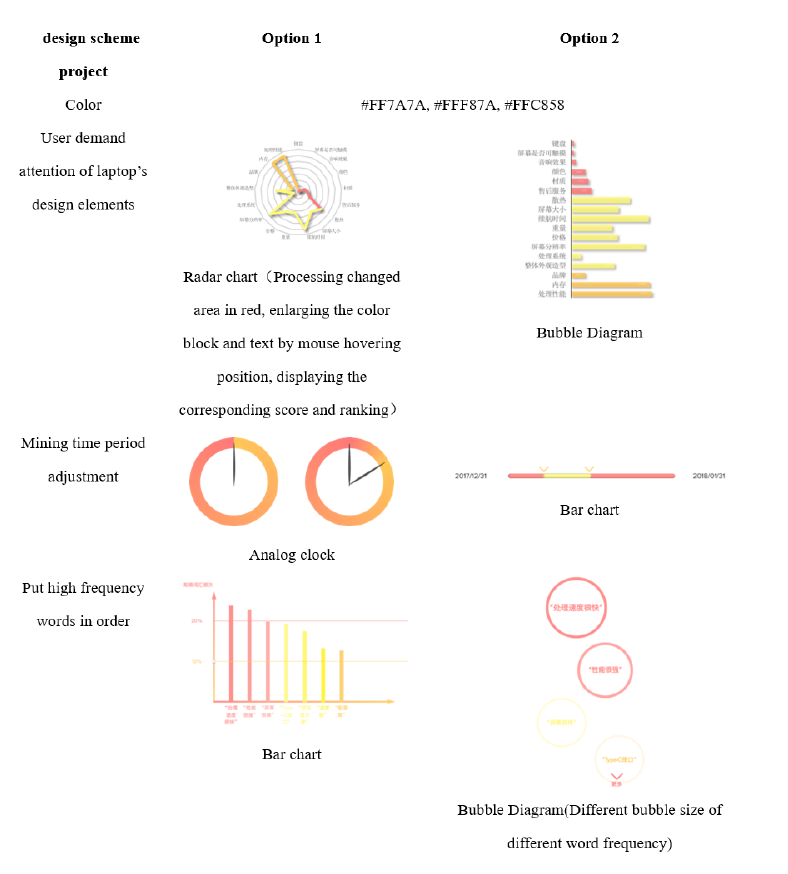
Figure 5. Two design schemes of data visualization.